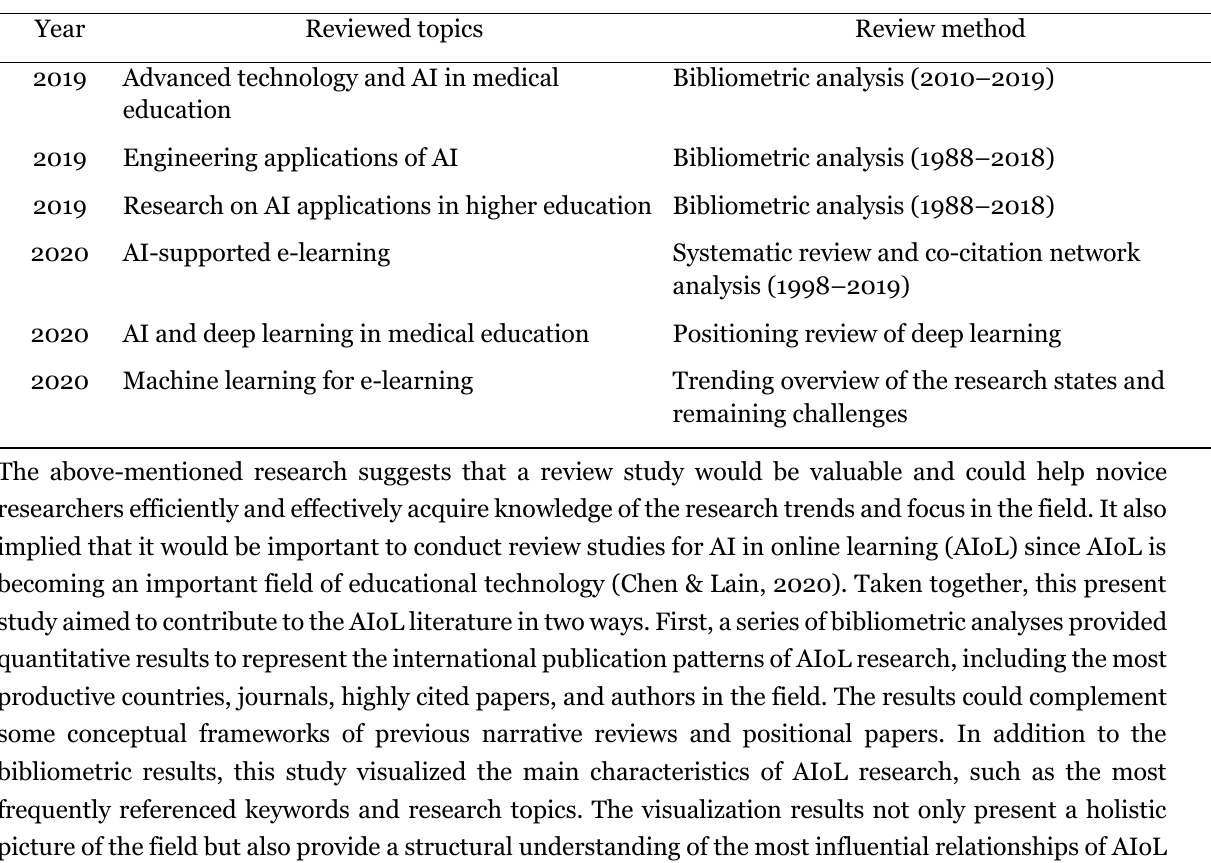
A List of Recent AI-Related Review Studies With an Education